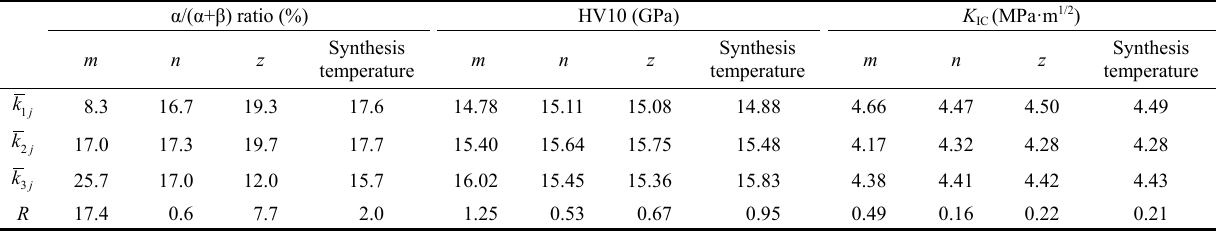
b k denotes the average result of each factor at each level in Table 1, where j ( j = 1, 2, 3, 4) is for the factor ( m , n , z values and synthesis temperature), ij and i ( i = 1, 2, 3) is for the levels ((1), (2), and (3)). For instance, S2, and S3, whose m values are the first level of 1.0 ((11% + 12% + 2%)/3 = 8.3%). The effect of different levels of factors can be determined by k in column j comparing ij